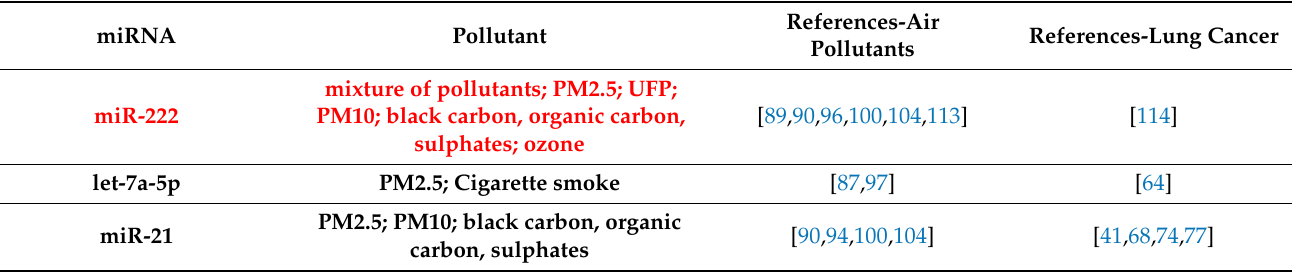
Table 3. A summary of miRNAs identified to be deregulated in lung cancer, as well as in air pollution-exposed subjects.